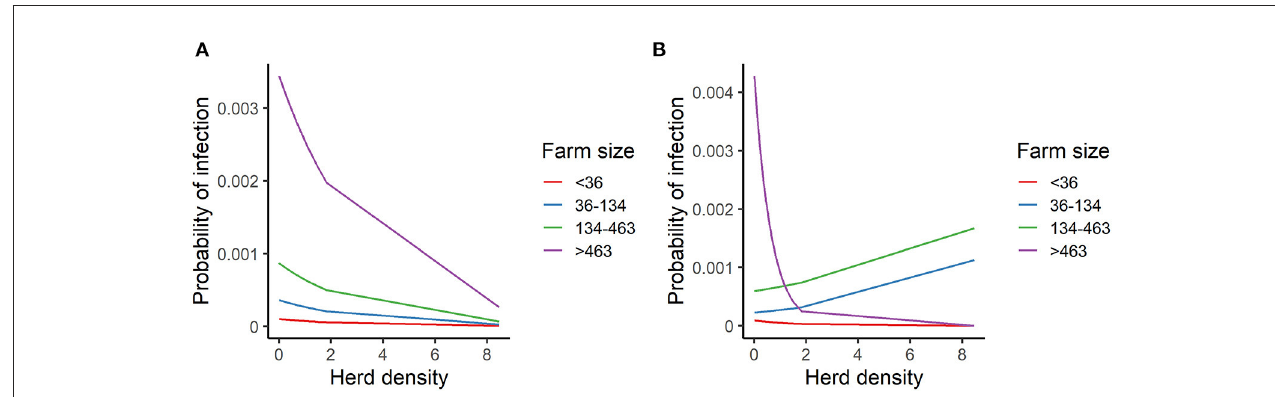
FIGURE3 Predicted probability of FMDV infection for herd density across the farm size strata. (A) Model without interaction. (B) Model with